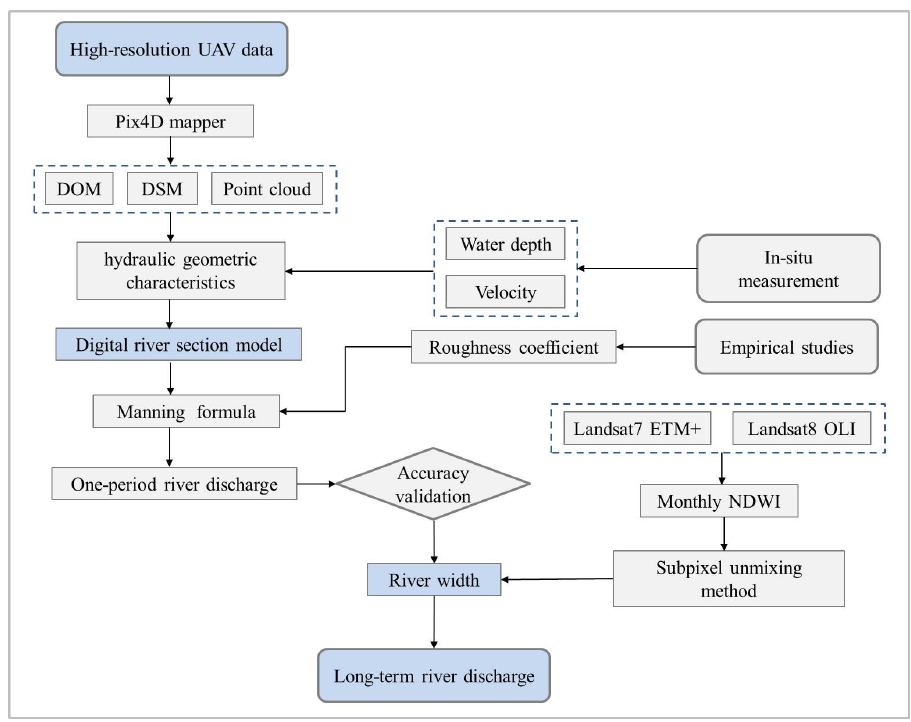
Figure 3. Flowchart of remote sensing hydrological station technology.